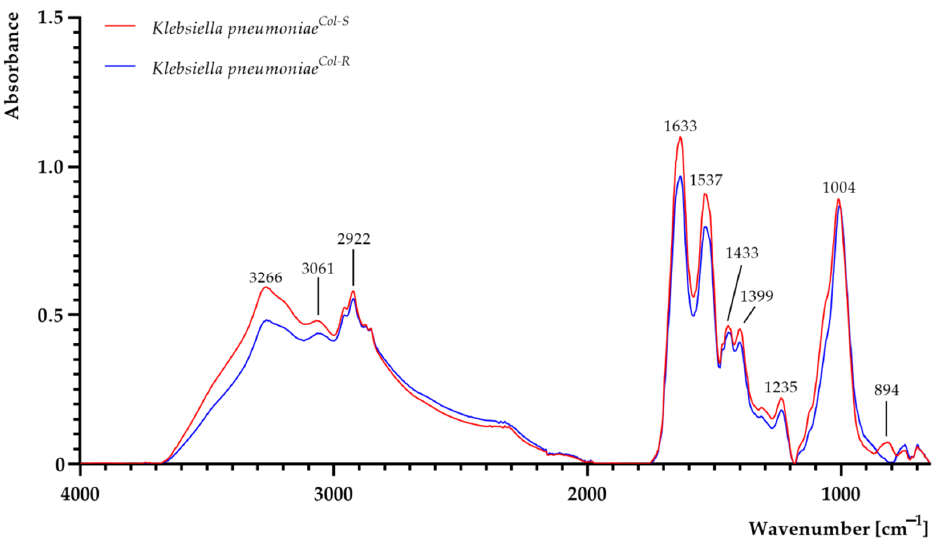
Figure 2. FTIR spectra of colistin-susceptible ( K. pneumoniae Col-S ) and laboratory-induced high-level colistin-resistant K. pneumoniae ( K. pneumoniae Col-R ) strains.